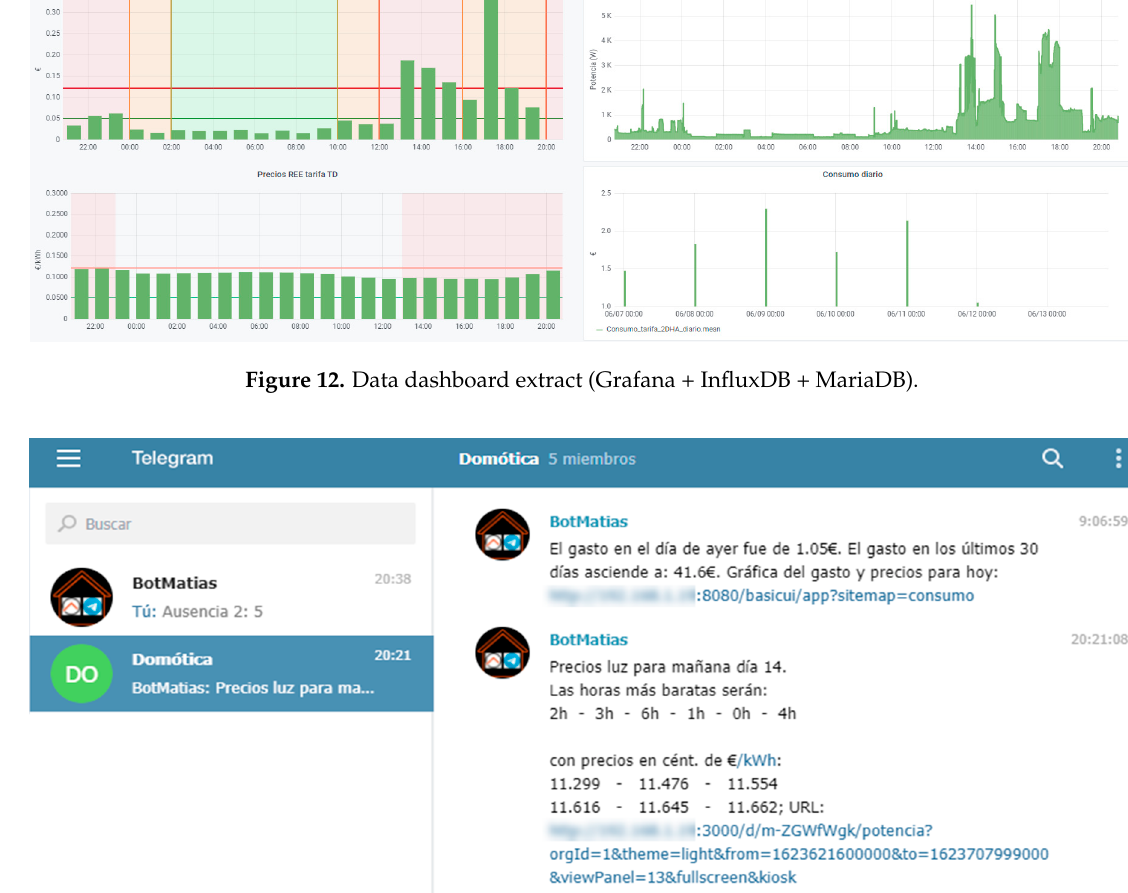
Figure 13. Example of text messages and images sent by the system to residents (Telegram).